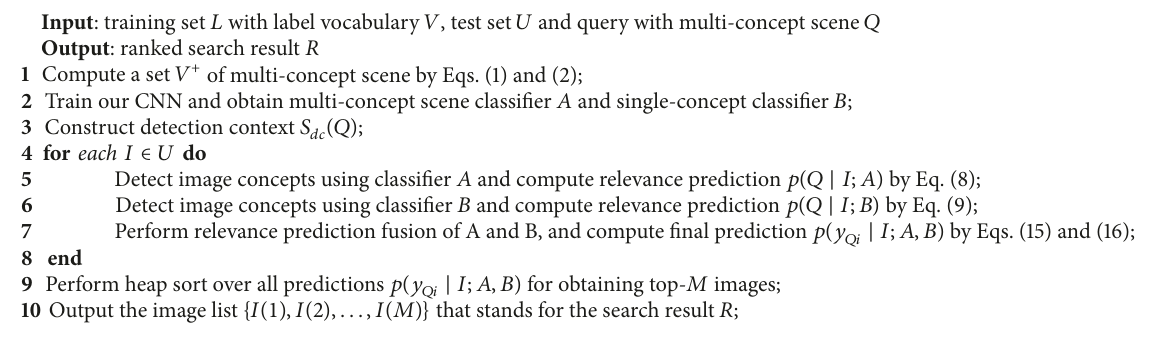
Algorithm 1: Semantic image retrieval